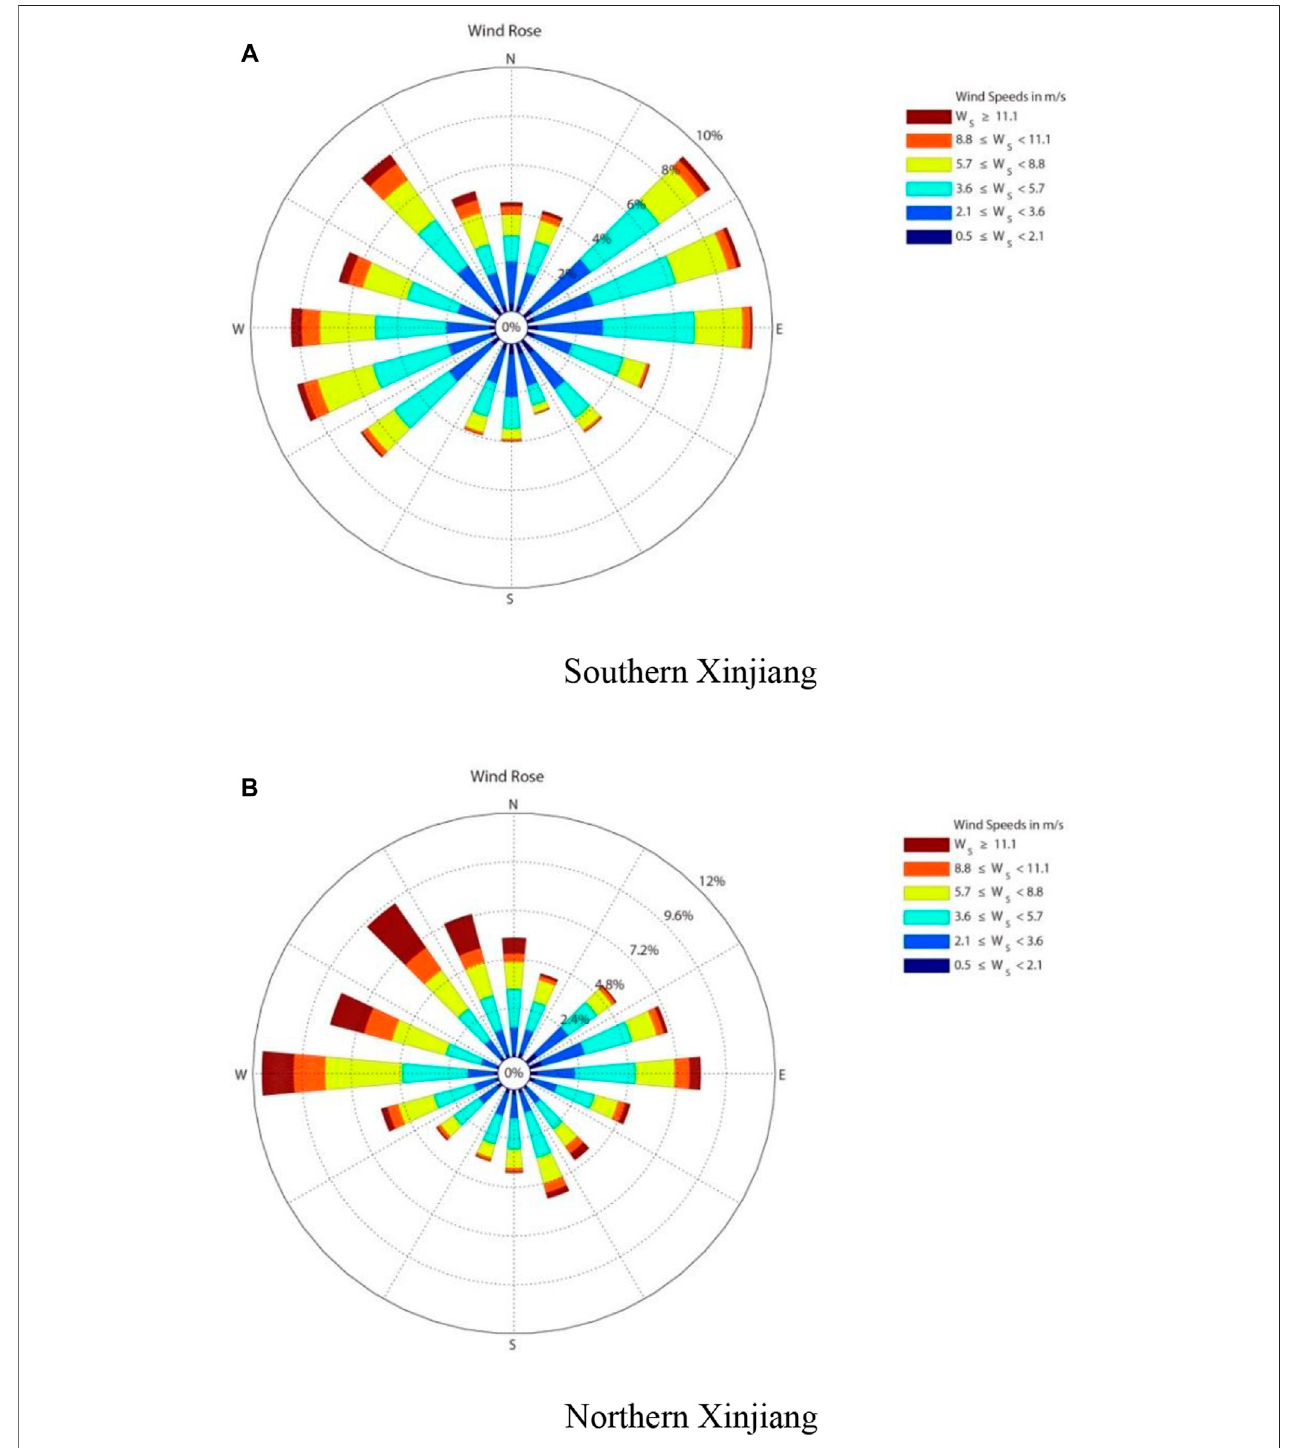
FIGURE 4 | Wind rose diagram: (A) Southern Xinjiang. (B) Northern